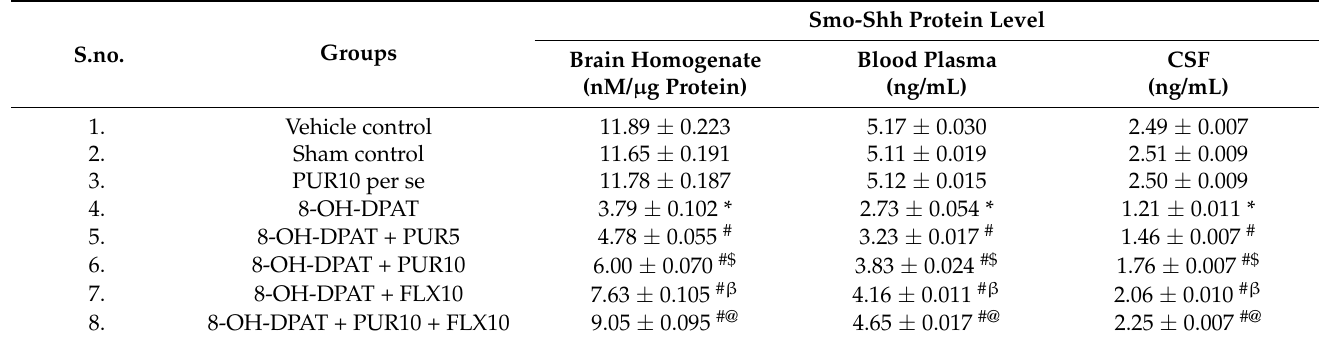
Table 1. Effect of purmorphamine on the restoration of Smo-Shh level in 8-OH